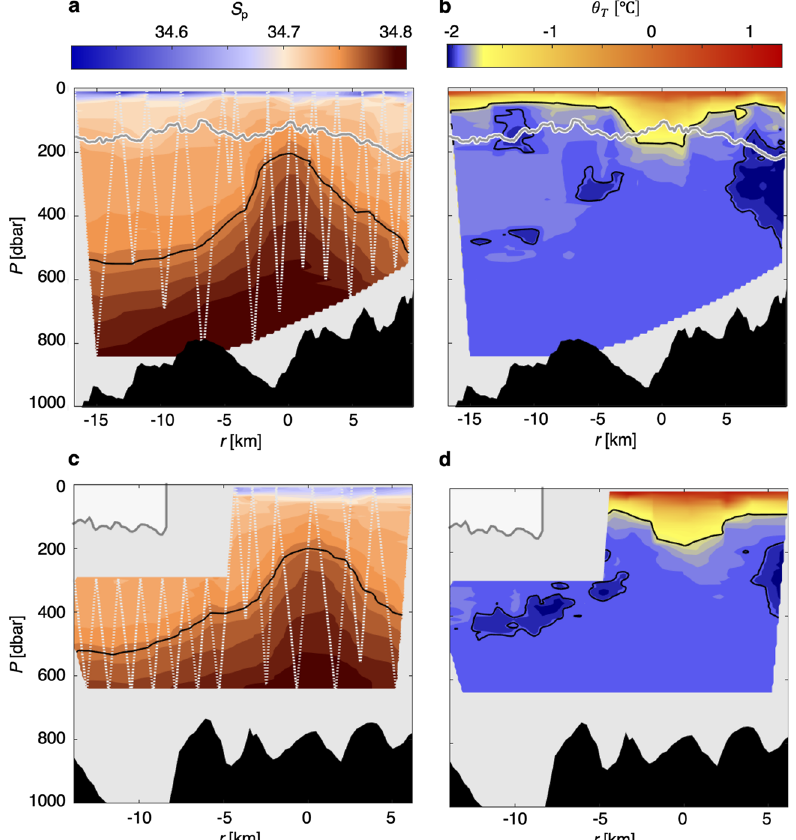
Fig. 5 Eddy vertical cross sections. a Practical salinity parallel to the NIS calving front (red lines in Fig. 1b). b Potential temperature parallel to the NIS calving front. c Practical salinity perpendicular to the NIS calving front (blue lines in Fig. 1b). d Potential temperature perpendicular to the NIS calving front. Grey lines in a , b and light grey polygons in c , d provide the nearby ice draft. Black contours in a , c show the upper extent of the HSSW. Black contours in b and d above/below 200 m show the extent of ASW/ISW. Vertical dashed lines show the extent of the data (glider path) before interpolation and black regions indicate sea fl oor bathymetry. The grey background signi fi es regions of no data. Vertical cross sections of data observed during eddy formation are provided in Supplementary Fig.